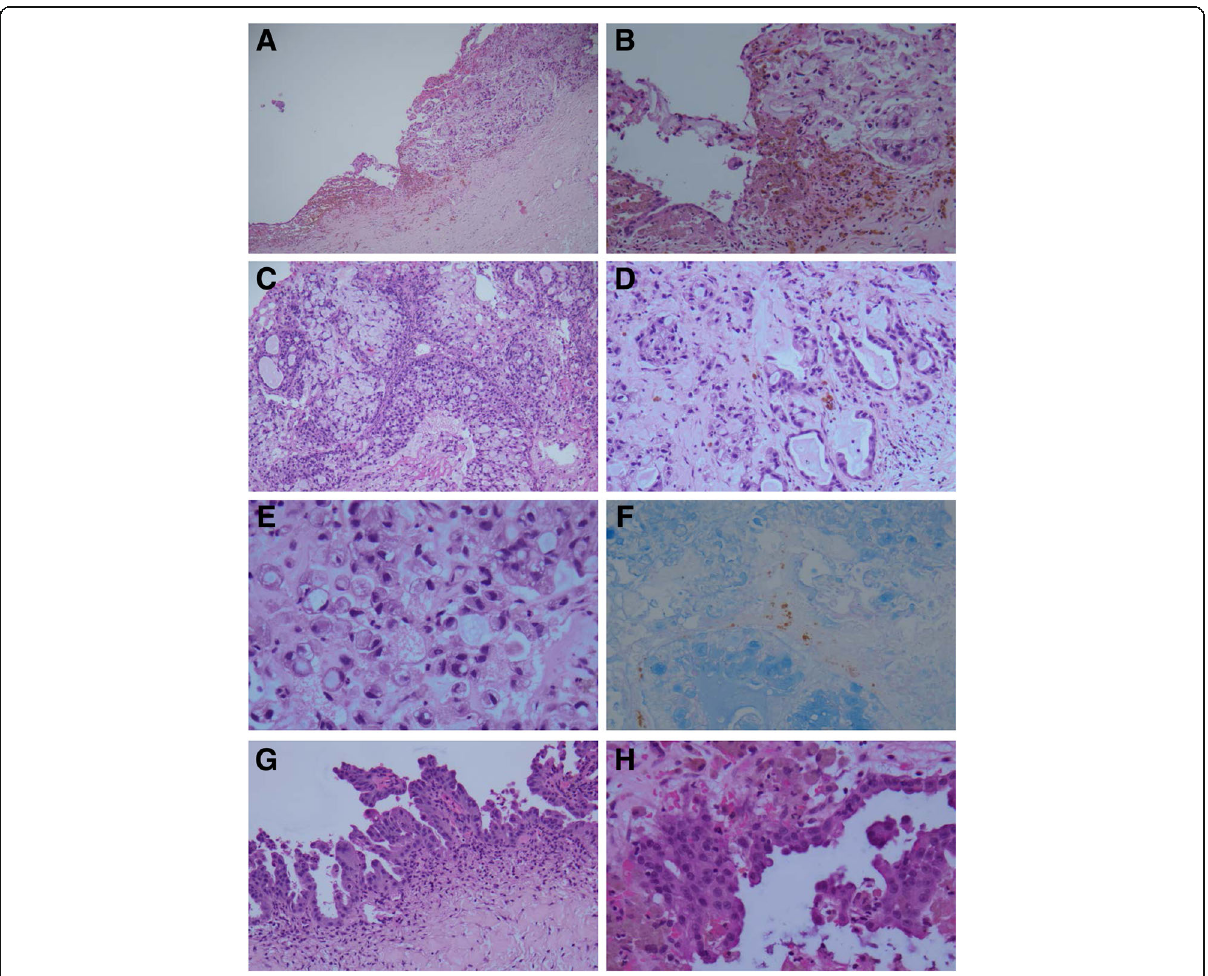
Fig. 1 Histopathology of the poorly differentiated mucinous carcinoma with signet ring cells of the ovary. The small carcinomatous nodule is continuous with the epithelium of the endometriotic cyst [ a , b ]. The tumor cells arranged in solid nests with occasional cribriform structure and crowded small neoplastic glands with marked nuclear atypia [ c , d ]. Signet ring cell carcinoma can be frequently seen [ c , e ]. The cytoplasmic mucin of the tumor cells is Alcian Blue positive [ f ]. Atypical surface epithelium in the endometriotic cyst exhibits cellular stratification, small papillation and variable cytological atypia [ g , h ]. Original magnifications: a × 50; b , d , f , g × 200; c × 100; e , h ×